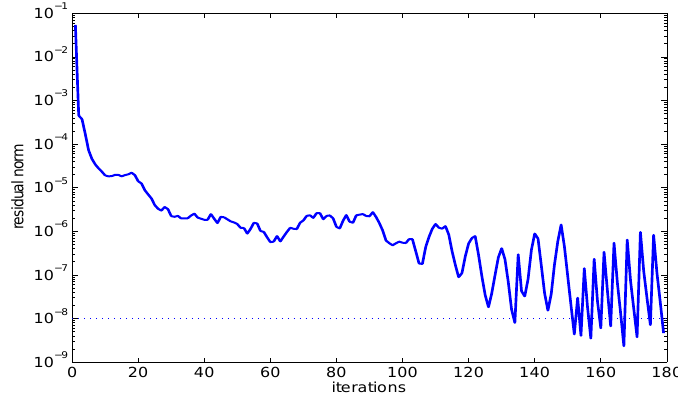
Figure 4. Convergence history: nonlinear Arnoldi with incomplete LU preconditioner.